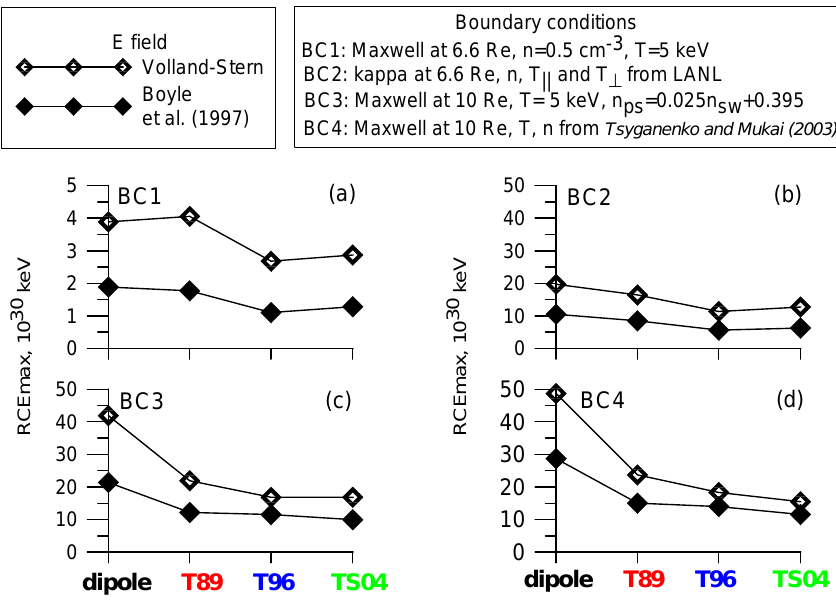
Fig. 4. Peak magnitudes of the ring current energy profiles shown in Fig. 2 during 6–7 November 1997